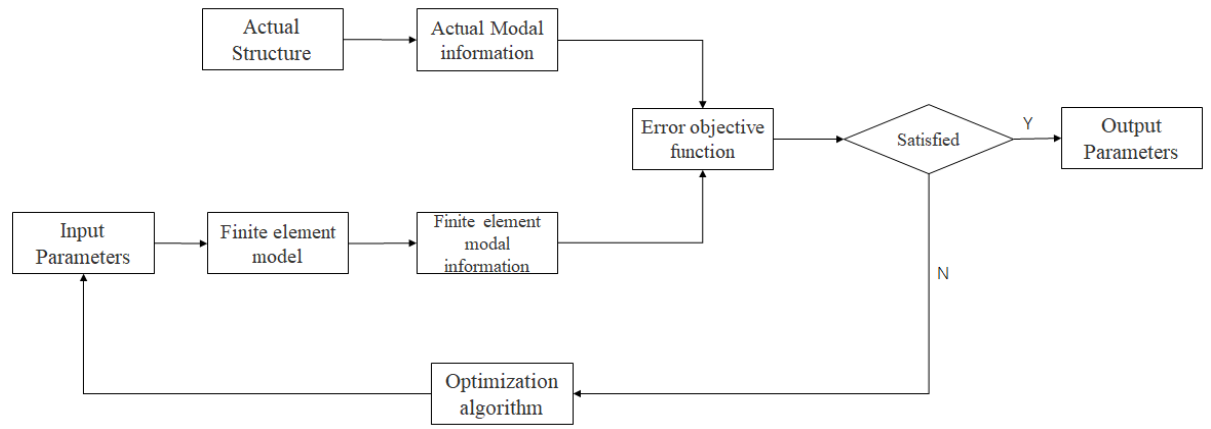
Figure 1. The damage identification problem is transformed into the optimization